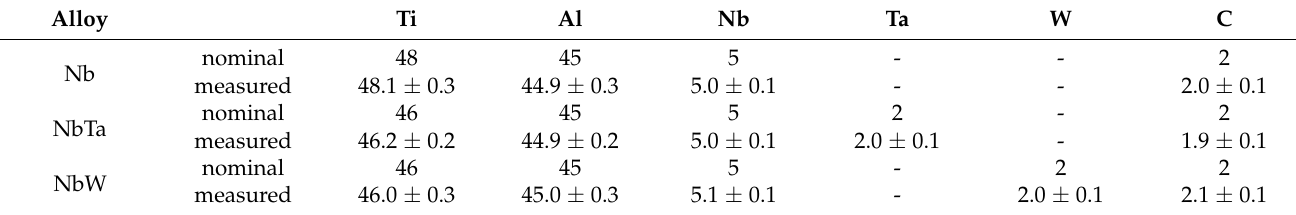
Table 1. Nominal and measured chemical composition of studied tilt-cast alloys